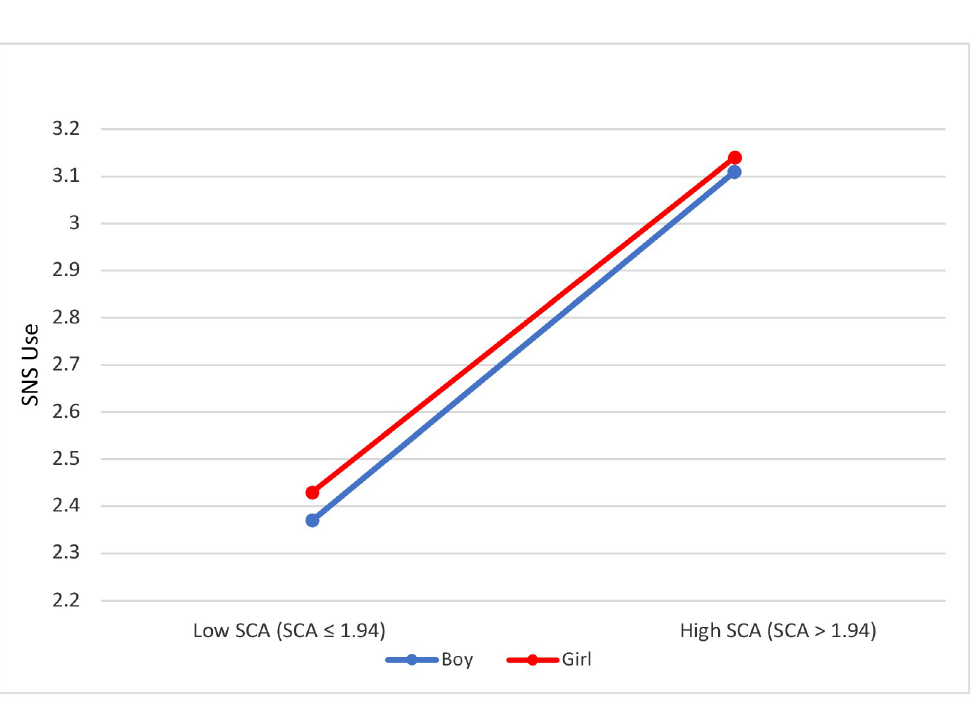
Fig 5. Social media use (SNS use) in girls and boys works similarly between high/low self-centered appearance focused use of social media (SCA).